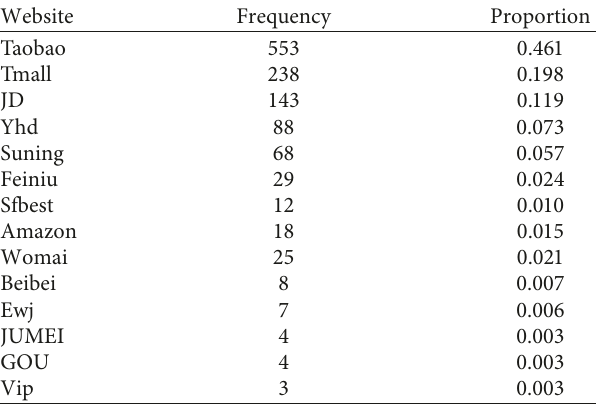
Table 2: Characteristics of e-commerce site sampled online.